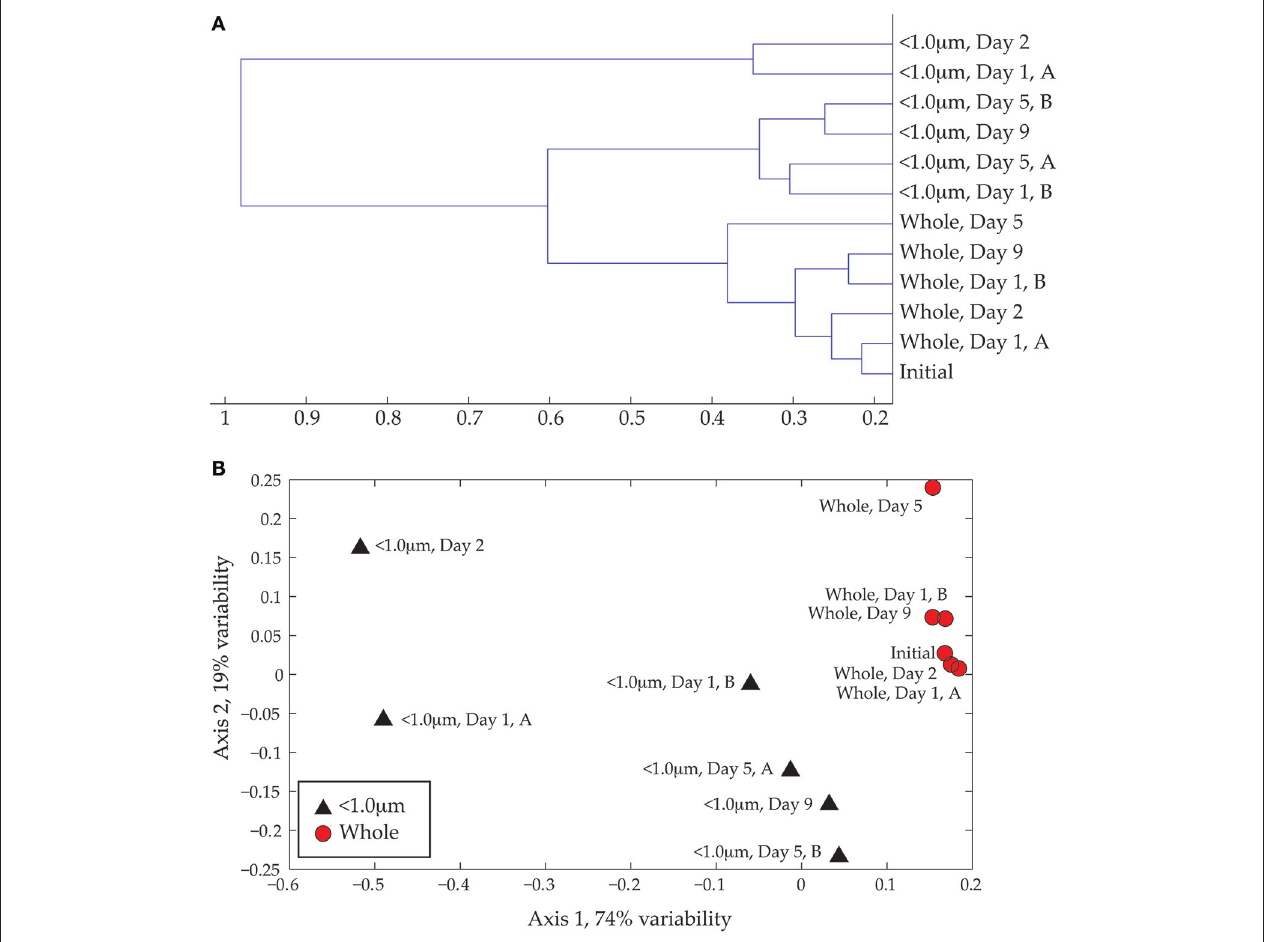
FIGURE 4 | (A) Cluster analysis of ESI FT-ICR positive-ion mode mass spectra. Similarities among spectra were assessed using the Bray-Curtis distance matrix calculated with presence/absence data. (B) Non-metric multidimensional scaling (NMS) ordination of same data. The < 1.0- µ m and the whole water data are shown with black triangles and red circles, respectively. The degree of variability represented by each axis was calculated using a Mantel test (see text) and is shown in the axis label. The stress for this ordination is 0.029 and the r 2 is